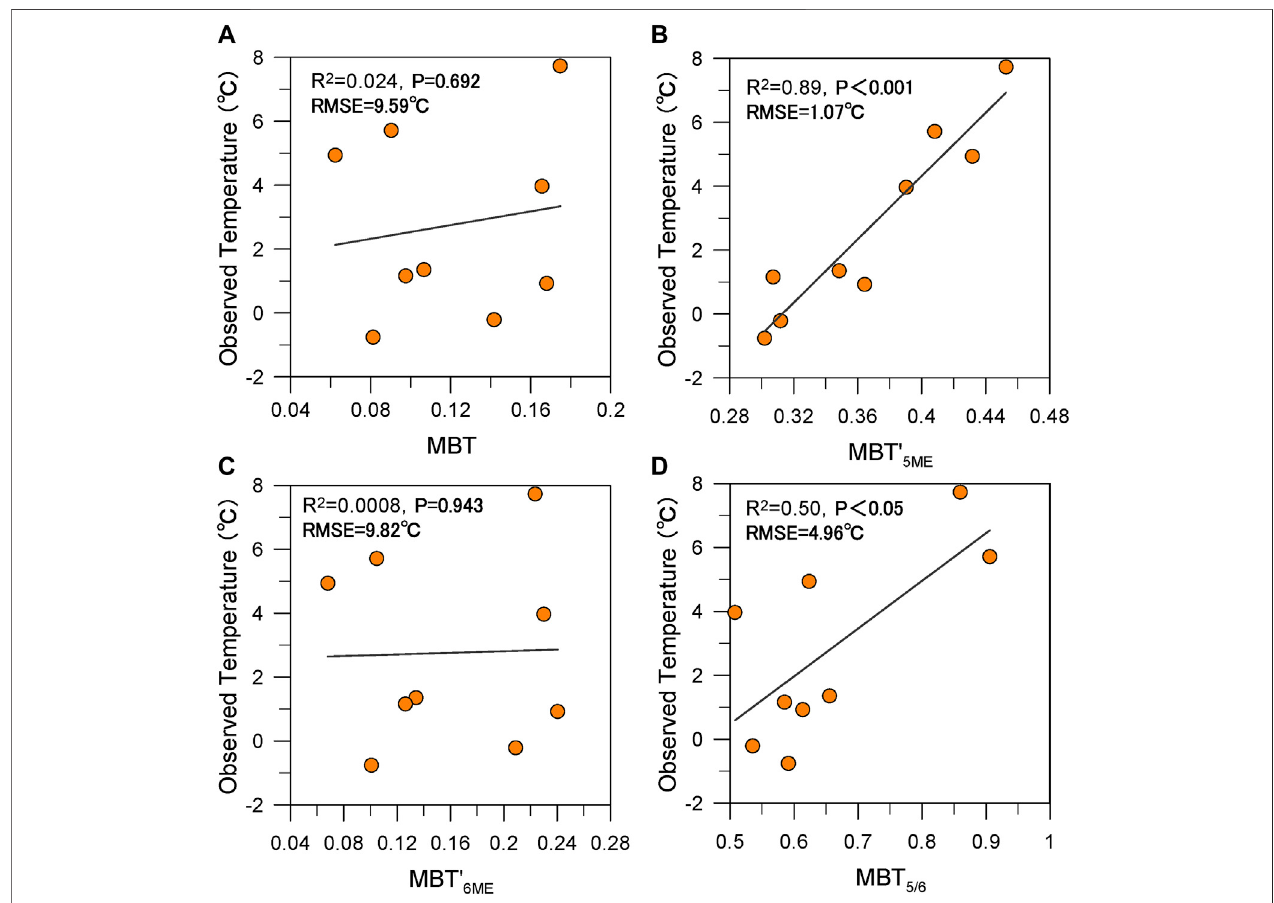
FIGURE4| CorrelationdiagramsbetweenbrGDGTsindexandtemperature. (A) CorrelationbetweenMBT ′ 5ME andtemperature; (B) correlationbetweenMBT ′ 6ME and temperature; (C) correlation between MBT 5/6 and temperature; and (D) correlation between MBT and temperature.